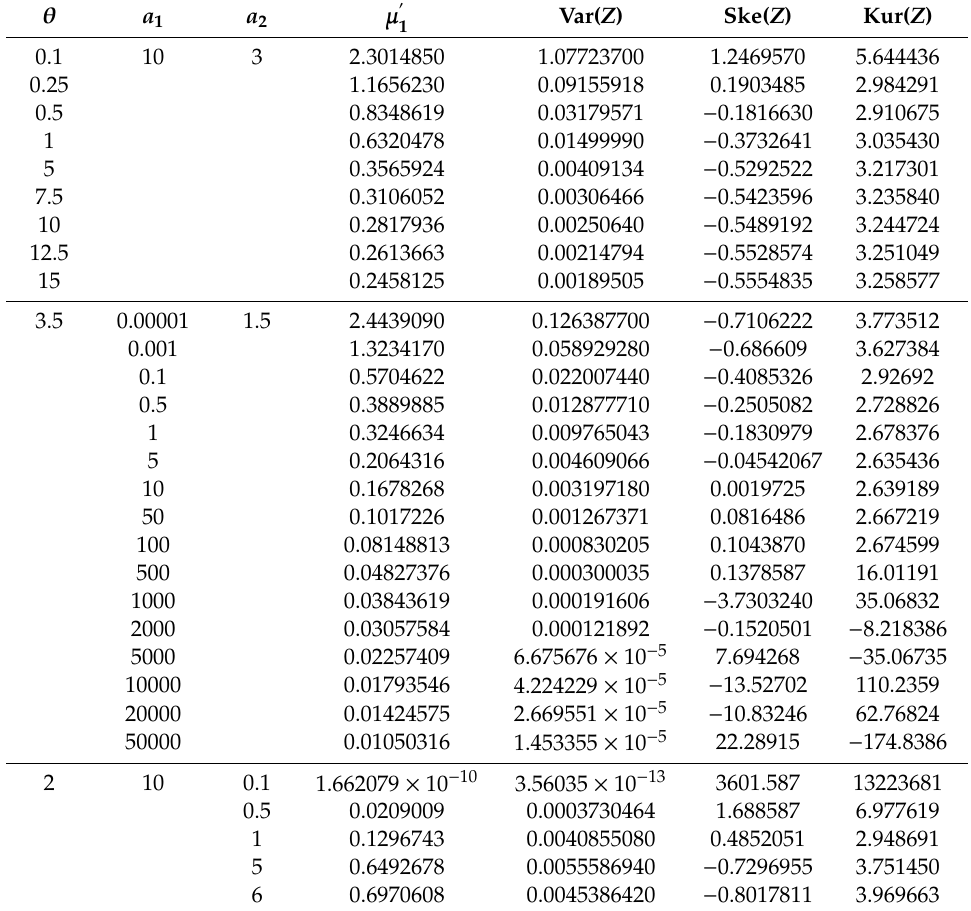
, Var( Z ), Ske( Z ), Kur( Z ) for the RG-LL model. 1